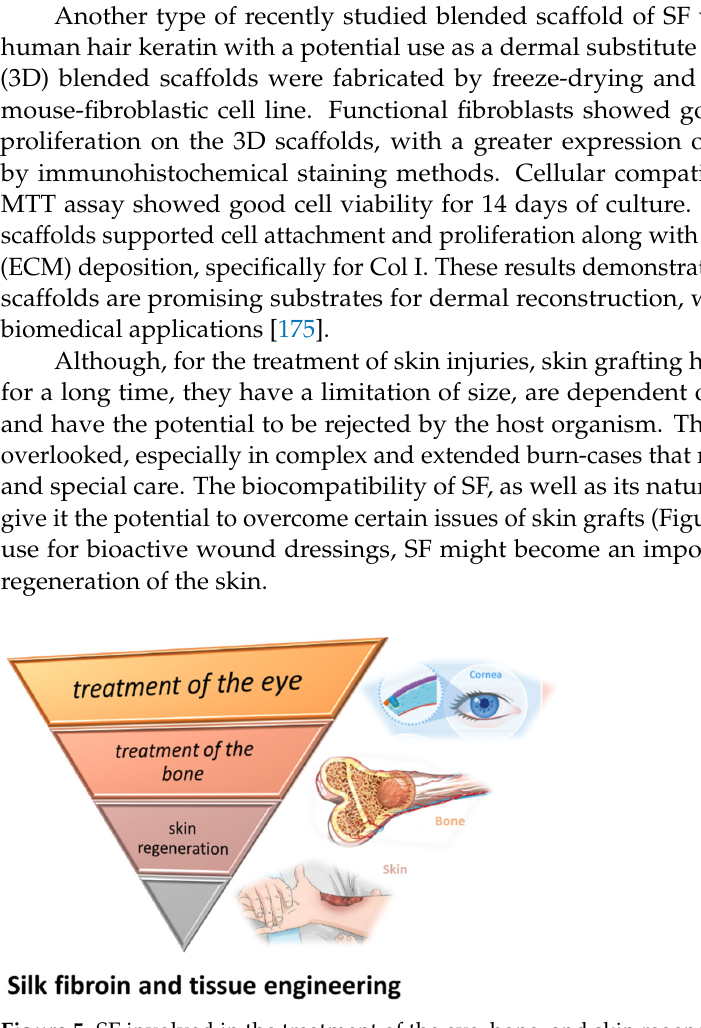
Figure 5. SF involved in the treatment of the eye, bone, and skin